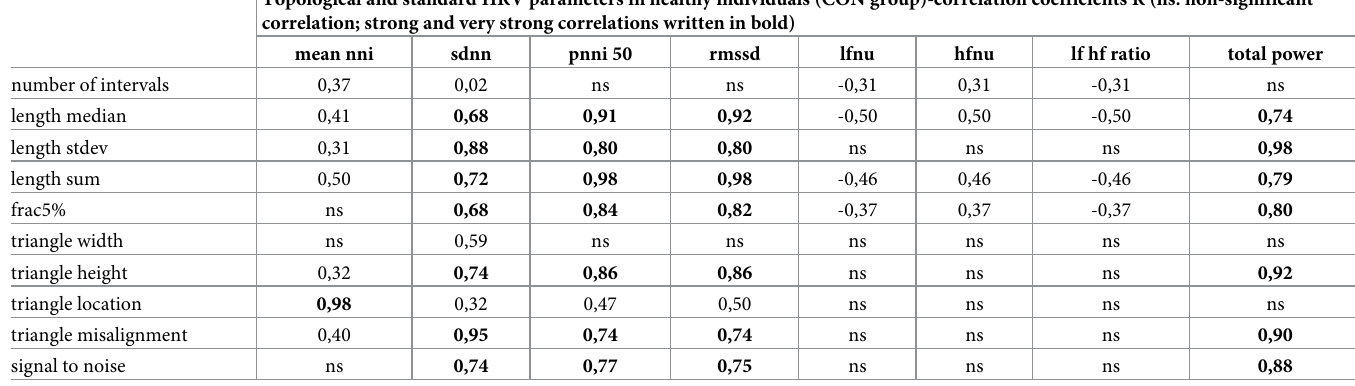
Table 1. Correlations between selected topological and standard hrv parameters in healthy individuals. Topological and standard HRV parameters in healthy individuals (CON group)-correlation coefficients R (ns: non-significant correlation; strong and very strong correlations written in